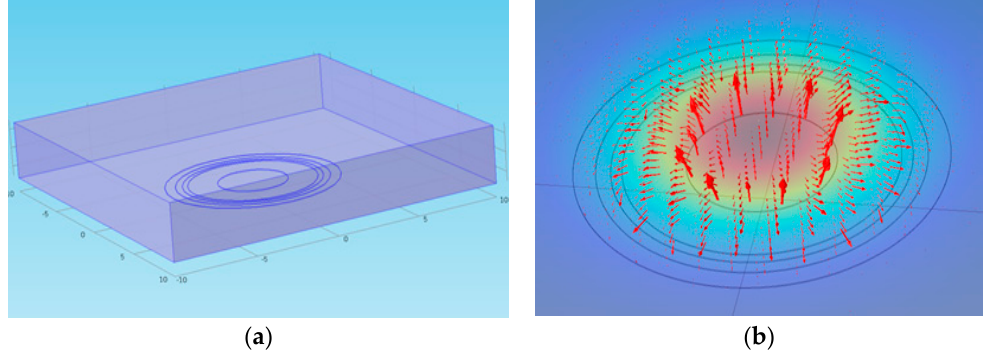
Figure 5. ( a ) Calculation domain of the electrical potential analysis; and ( b ) electrical potential field around the electrodes